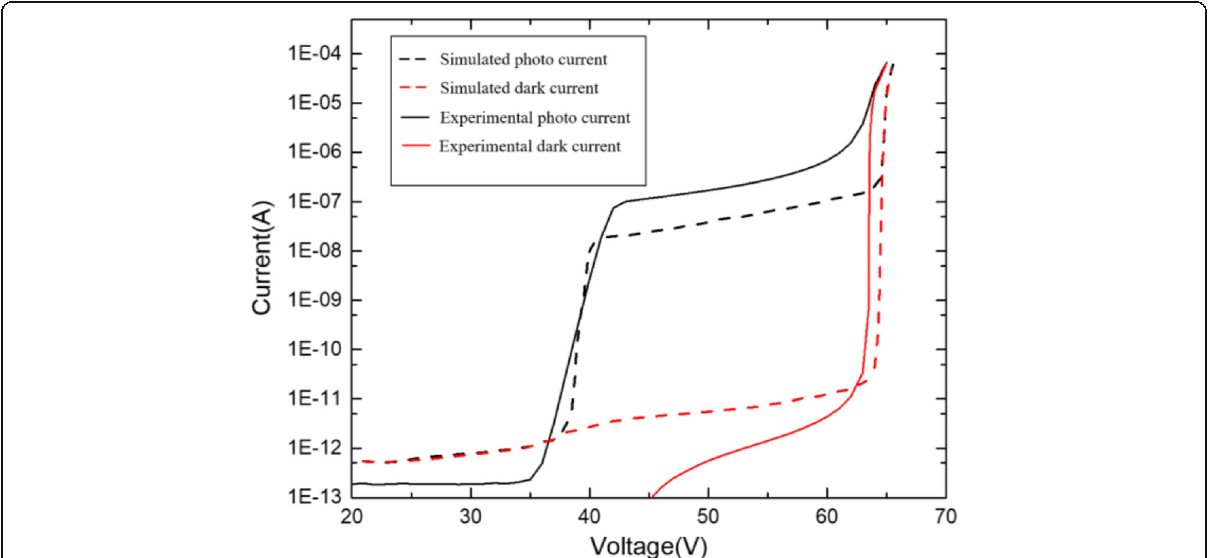
Fig. 8 Simulation results compared with the experiment results (photocurrent and dark current). Black dashed line: simulated photo current. Red dashed line: simulated dark current. Black solid line: experimental photo current. Red solid line: experimental dark current. Presents the comparison of the simulation results and experiment results. The simulation model uses the same parameters from the experiment in the